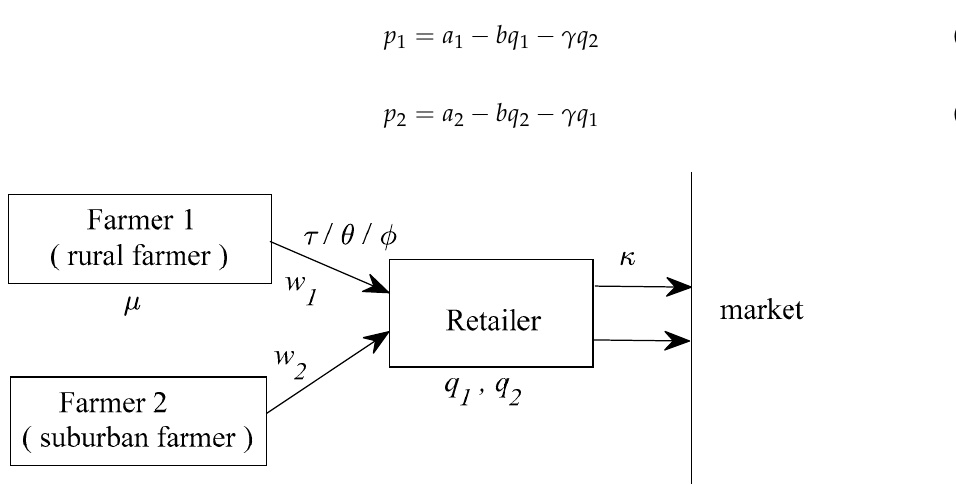
Figure 1. Two-echelon two-to-one development supply chain structure. Table 2. Explanation of CSR